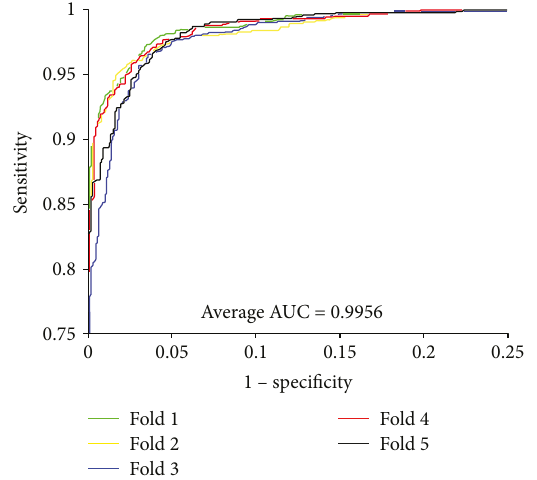
Figure 5: ROC curves performed by the proposed approach on the S. cerevisiae dataset.